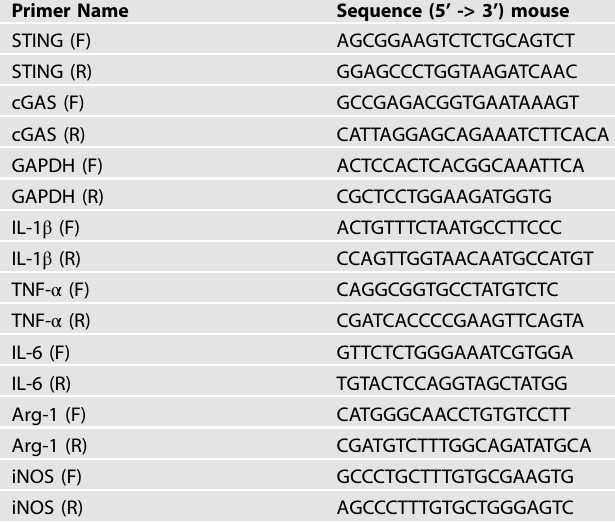
Table 1. Primer sequences used in this part of the